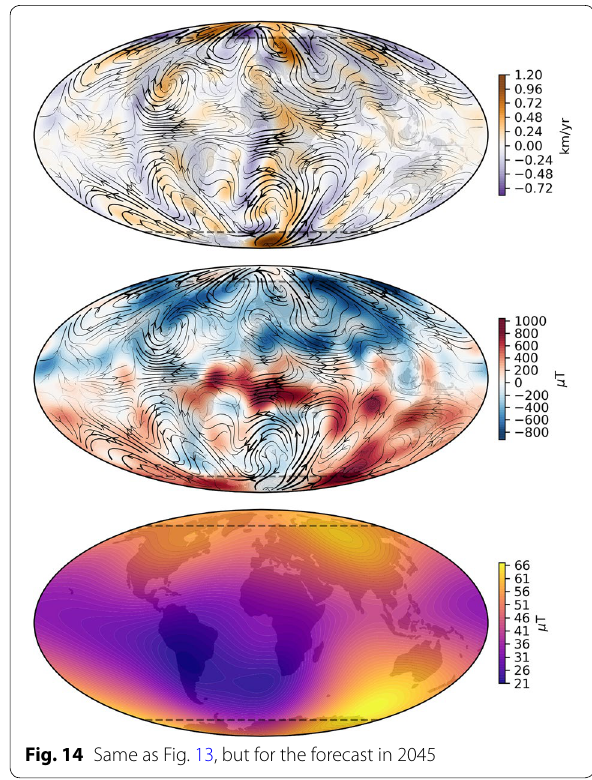
Fig. 14 Same as Fig. 13, but for the forecast in 2045